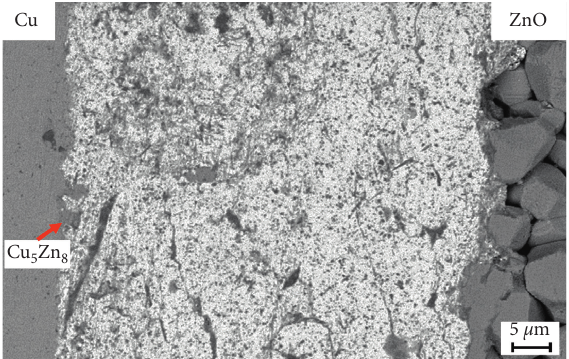
Figure 5: Cross-sectional SEM micrograph of ZnO/Cu joint bonded with Sn 8 Zn 3 Bi 1 Mg active solder.